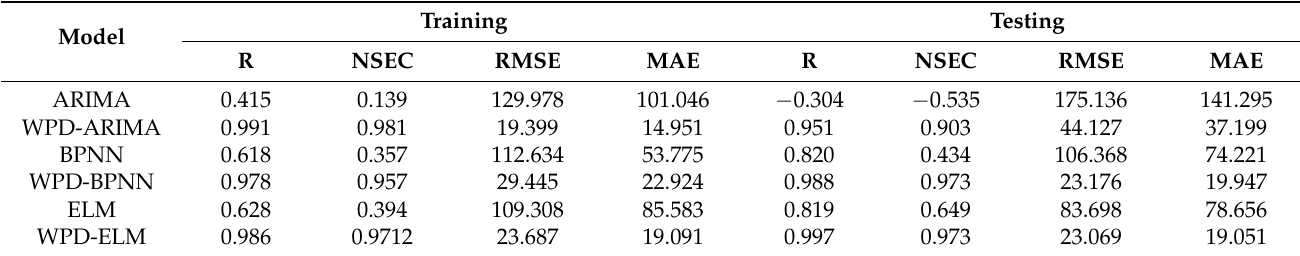
Table 4. Prediction performance of different models in training and testing phases.